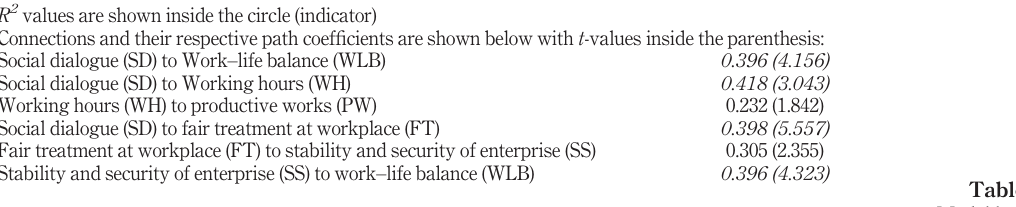
Table IV. Model legends